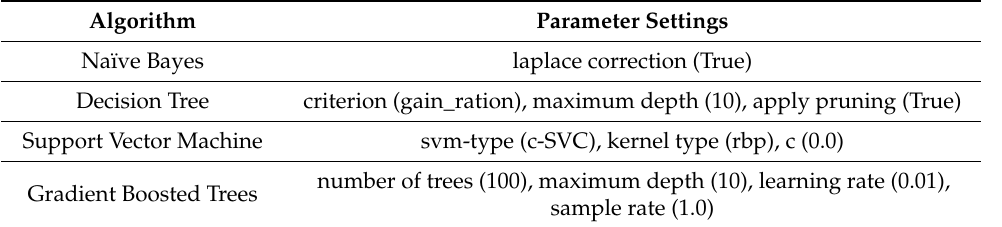
Table 2. Descriptions of parameter settings of shallow machine algorithms used for comparison with deep